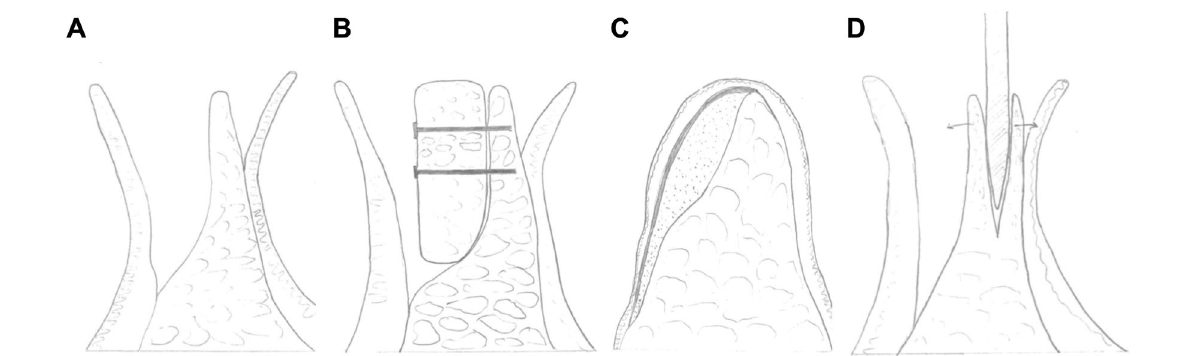
Fig. 2 Schematic of horizontal bone loss in the lower jaw after crestal gingival exposure ( A ). Principle of bone‑block grafting and fixation with screws ( B ). Depiction of lateral augmentation using particulate bone and membrane placement for coverage ( C ). Gaining of horizontal bone width by surgical splitting of the alveolar ridge ( D